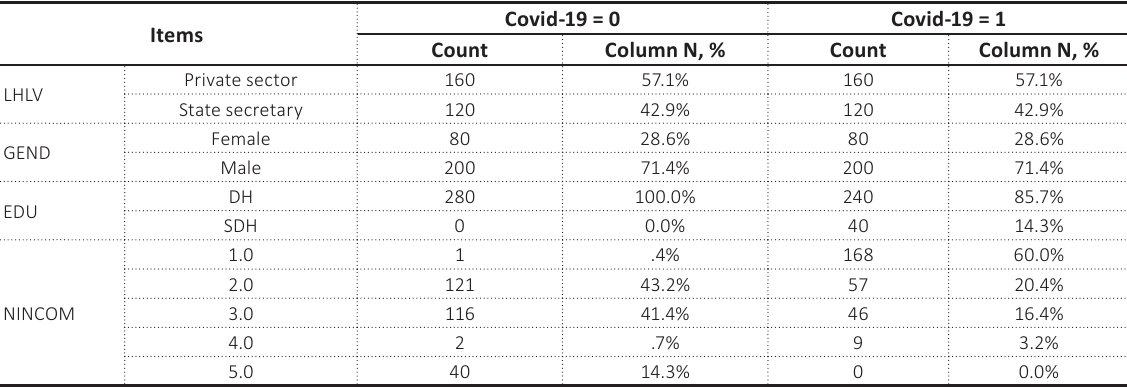
Table 1. Descriptive statistics of the study’s